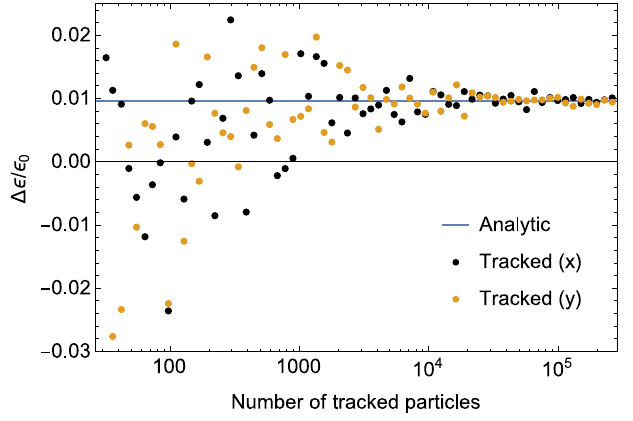
FIG. 5. Plot of relative projected emittance growth vs number of tracked particles, after E legant -tracking [19] a beam with 1% rms energy spread through the apochromatic lattice shown in Fig. 4(a). Approaching large particle numbers, the tracked emittance growth converges to the analytic estimate given by Eq. (18), with an expected statistical error ( ∼ 1 = lattice is antisymmetric, the emittance growth is (very nearly) identical in both